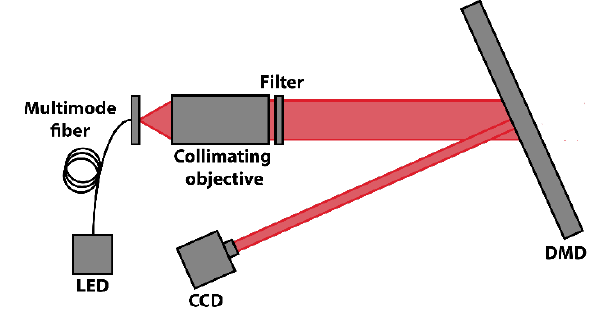
Fig. 1. DMD wavefront sensor based on Hartmann mask. The signal from the end of the optical fiber is collimated and